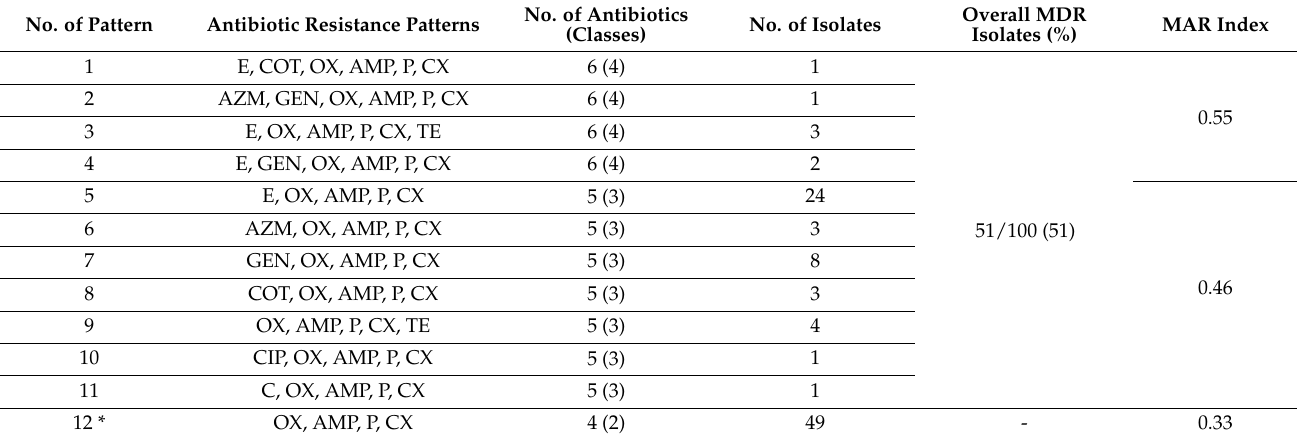
Table 4. MDR and MAR profiles of S. aureus isolates detected from different foods and hand swab